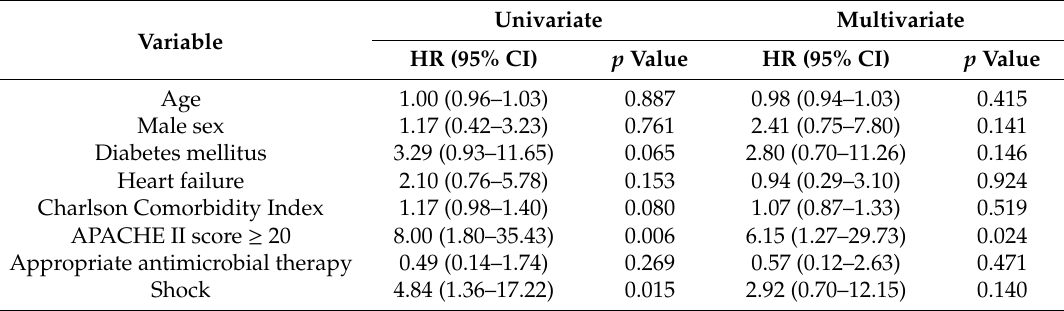
Abbreviations: APACHE, Acute Physiology and Chronic Health